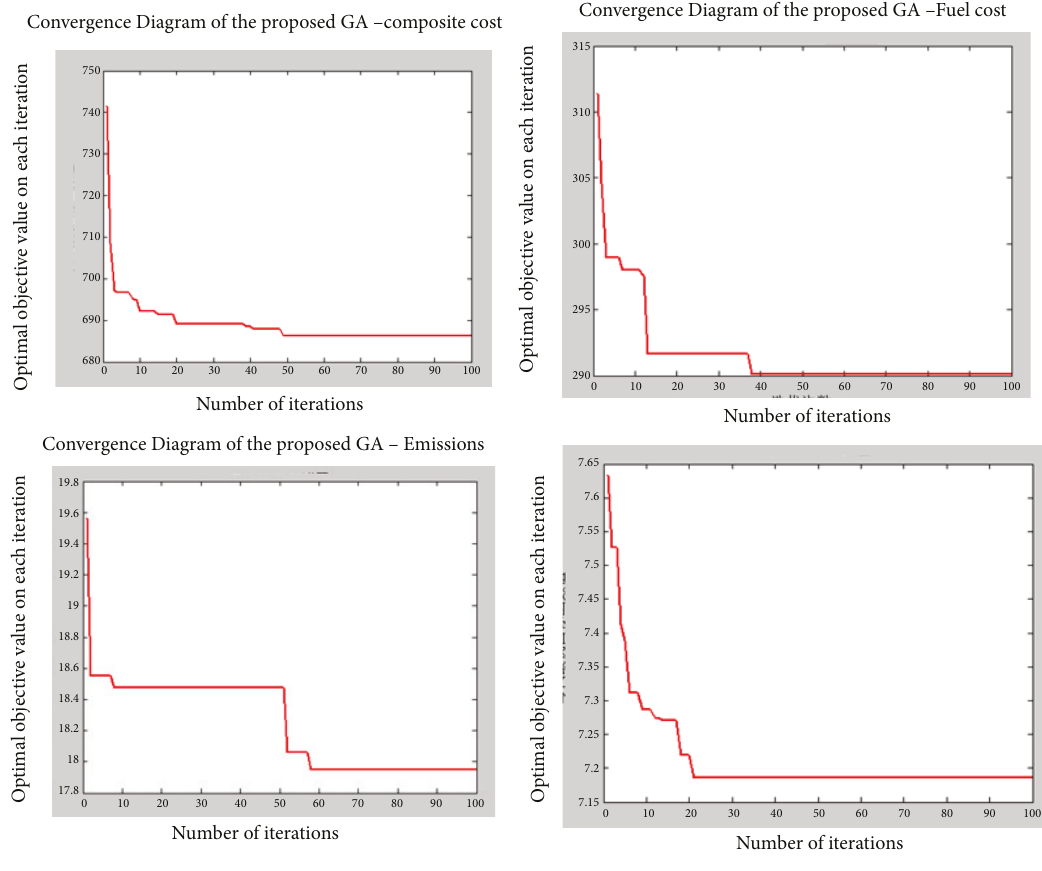
Figure 4: Test on algorithm convergence with different objectives.